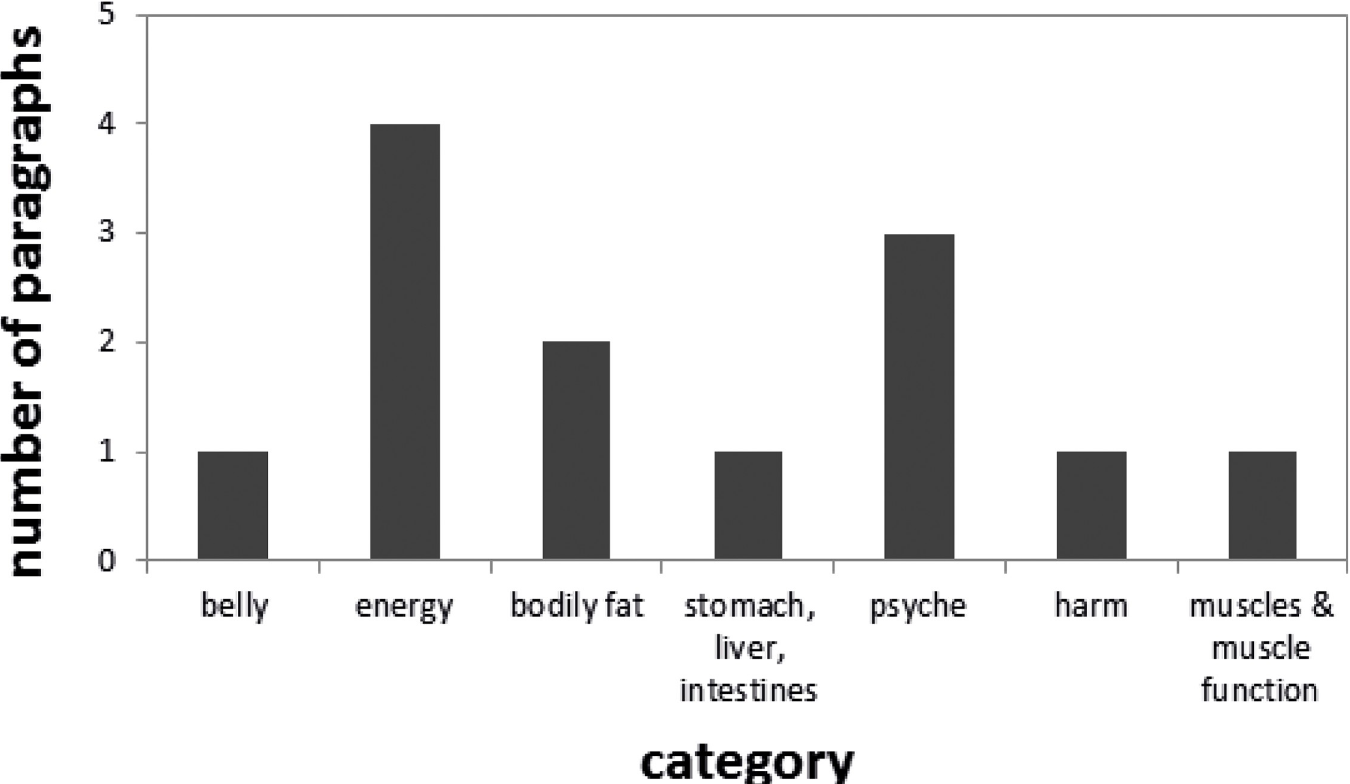
Fig 3. Number of positive paragraphs retrieved from the forum “Bodynet”, more specifically the thread “Supplementen”, for the dietary supplement Dexaprine, displayed per category (effect type).